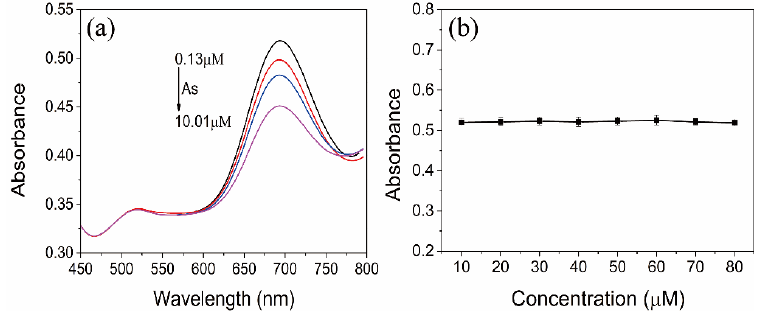
Figure 3. ( a ) UV–vis absorption spectra of DTT-AuNRs (0.8 nM) upon adding increasing concentration of As(III) ions (from 0.13 to 10.01 μM); ( b ) Effects of concentration of DTT on UV-vis spectra of AuNRs.